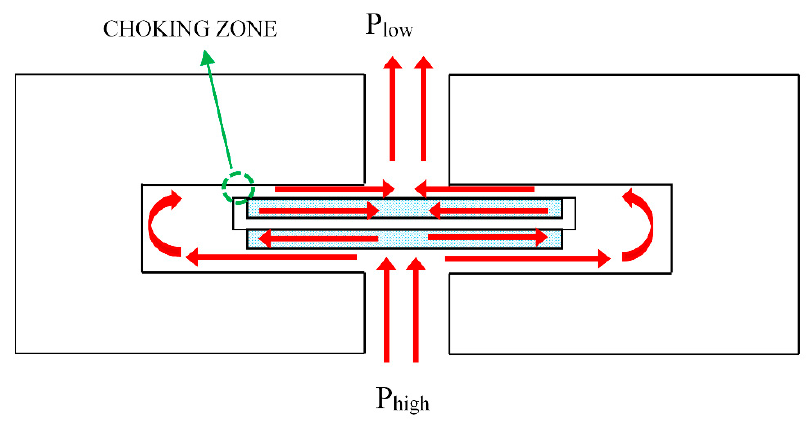
Figure 4. Fluid flow through the cloth seal.